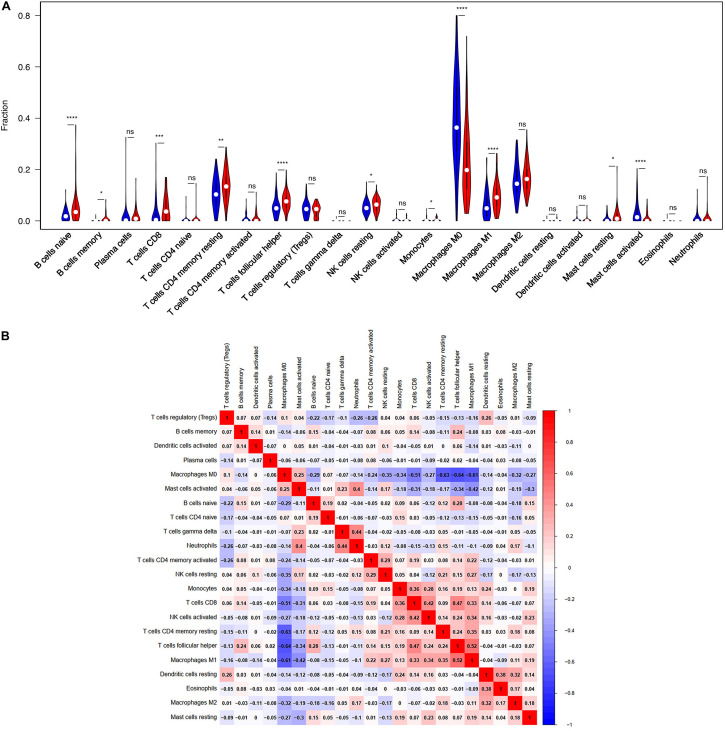
BTLA-related immune infiltration alteration. (A) The group with high expression of BTLA is red, and the group with low expression of BTLA is blue. Naive B cells, memory B cells, CD8 T cells, CD4 memory resting T cells, follicular helper T cells, resting NK cells, M1 macrophages and resting mast cells share a higher proportion in high expression group compared with low expression group. On the contrary, the proportion of monocytes, M0 macrophages, activated mast cells are apparently lower. (B) The proportions of different immune infiltration cells subpopulations were weakly to highly correlated. ns, p > 0.05; *p < 0.05; **p < 0.01; ***p < 0.001; ****p < 0.0001.